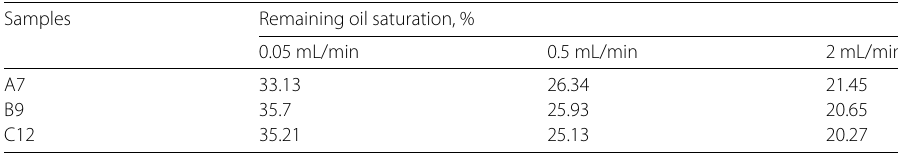
Figure 13 Comparison of remaining oil saturation from the prospective of theory and